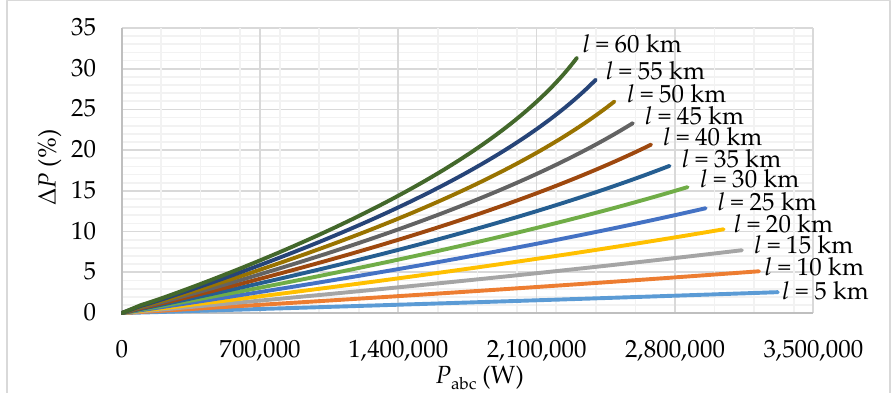
Figure 2. The dependence of increasing active power losses (APL) from three-phase active power consumption for aluminium conductor steel reinforced (ACSR) 42/7 without consideration of voltage dip.